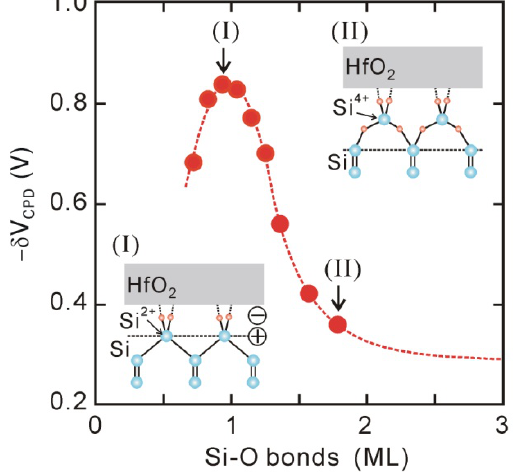
for direct-contact HfO /Si structures after various PDA processes, as a Figure 6. δ V CPD 2 function of Si-O thickness estimated by in-vacuum